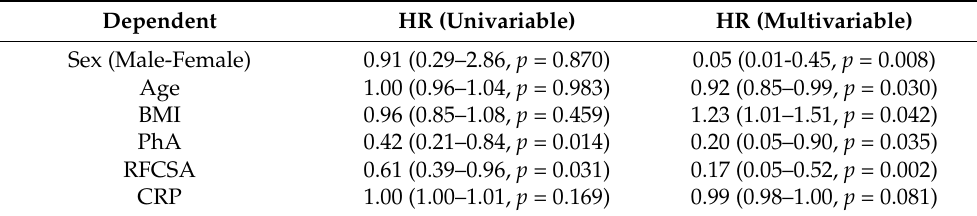
Table 4. Multivariable analysis of the prognostic factor for mortality in cancer patients.